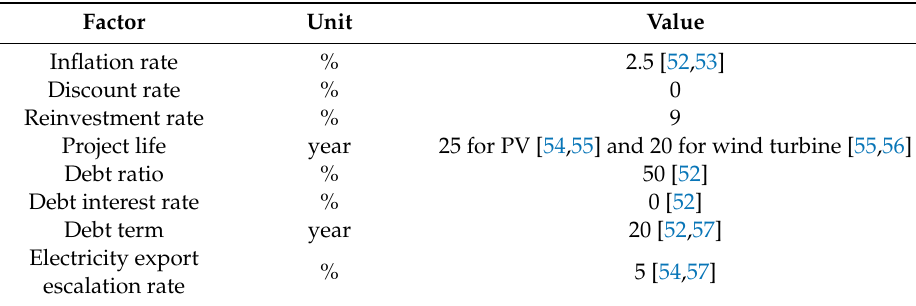
Figure 7. Annual electricity generation, capacity factor, and performance ratio of the proposed systems. Table 11. Financial